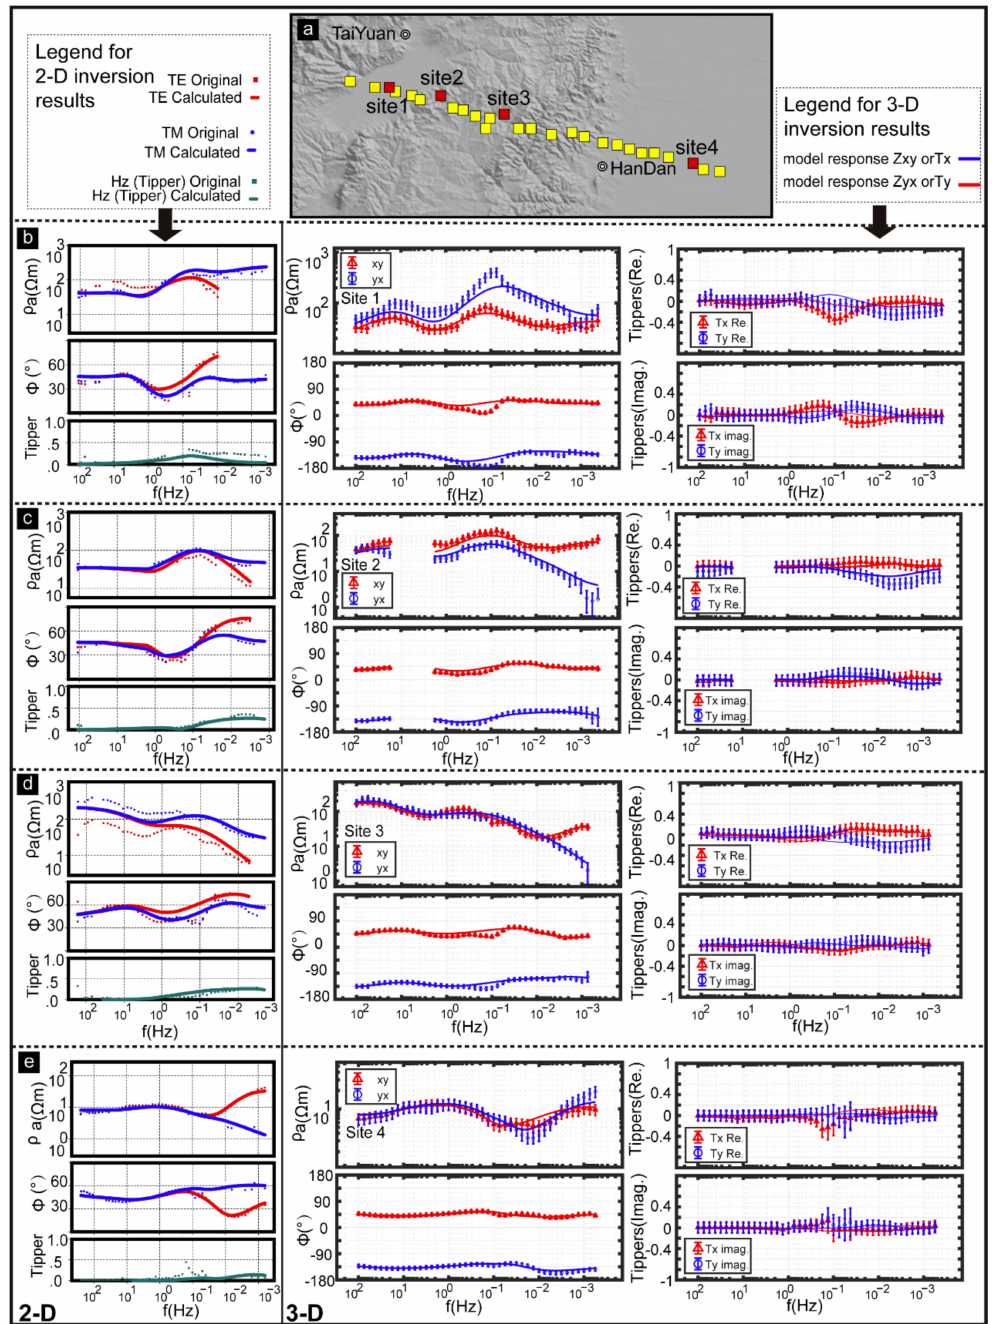
Figure 2. Typical apparent resistivity, phase curves and tippers for 4 sub-regions of the research area. ( a ) Locations of MT sites from 4 sub-regions. ( b – e ) show the typical curves from the Taiyuan Basin (TYB), Taihang Mountain (THM), and North China Plain (NCP), respectively. It’s notable that the impedance tensors for 2D inversion were rotated to a uniform strike direction, i.e., N45 ◦ E, while the impedance components for 3D inversion were